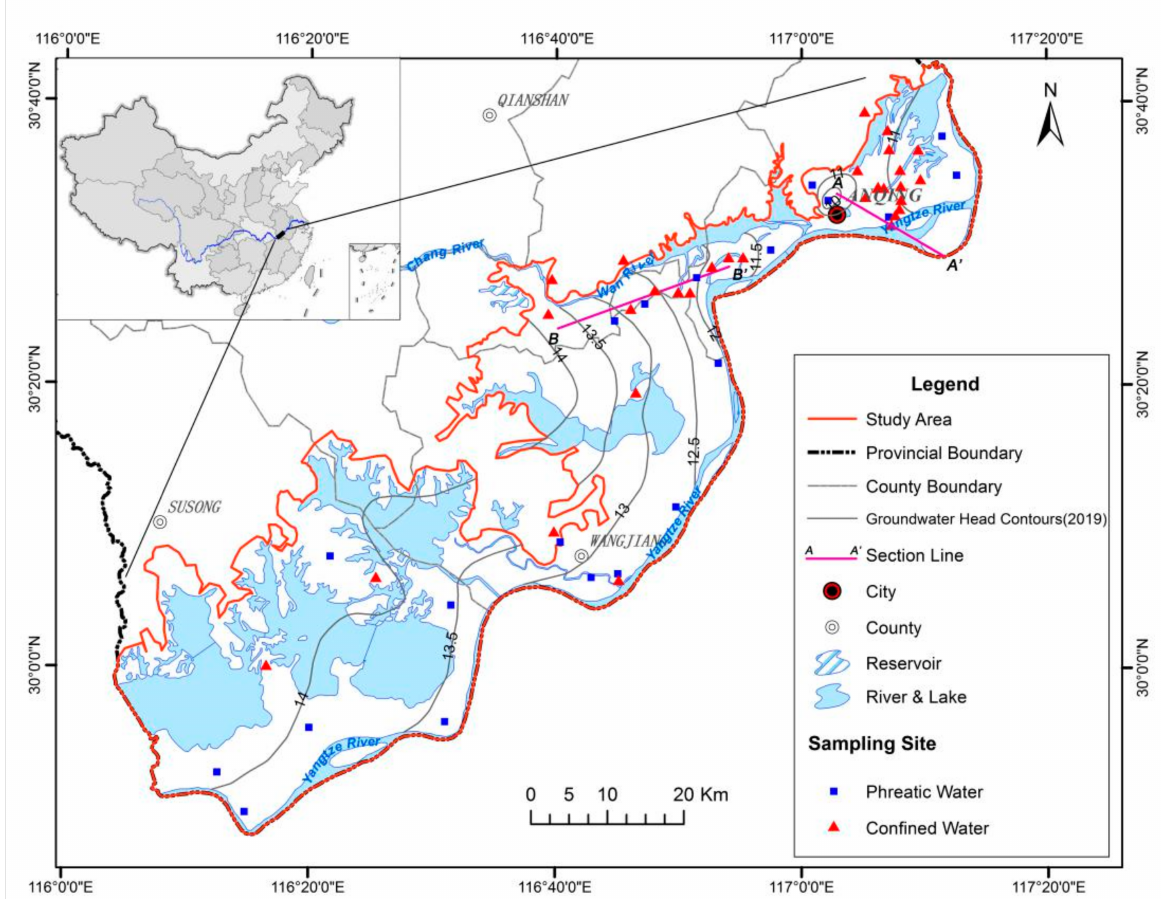
Figure 1. Alluvial plain (Anqing section) of the lower Yangtze River basin and sampling